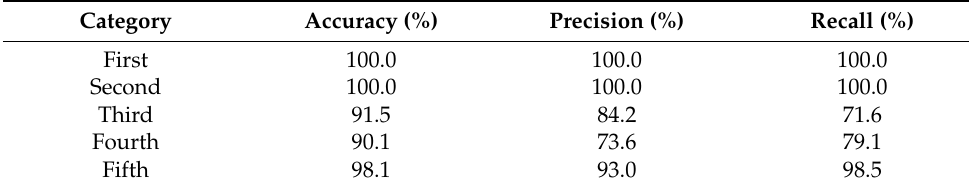
Table 1. The classification results for O-ResNet.